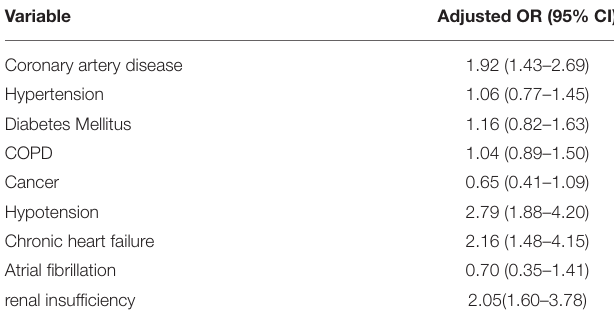
TABLE 3 | Multivariable predictors of myocardial injury after non-cardiac surgery.